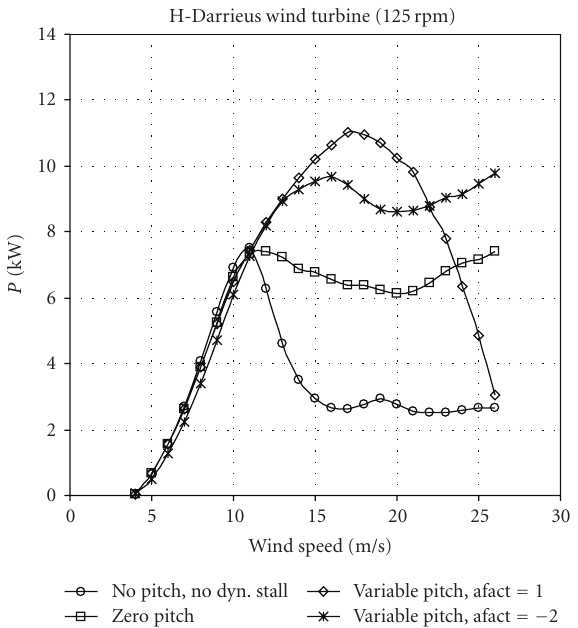
Figure 3: Power versus wind speed for the 7kW VAWT with fixed and variable pitch blades.